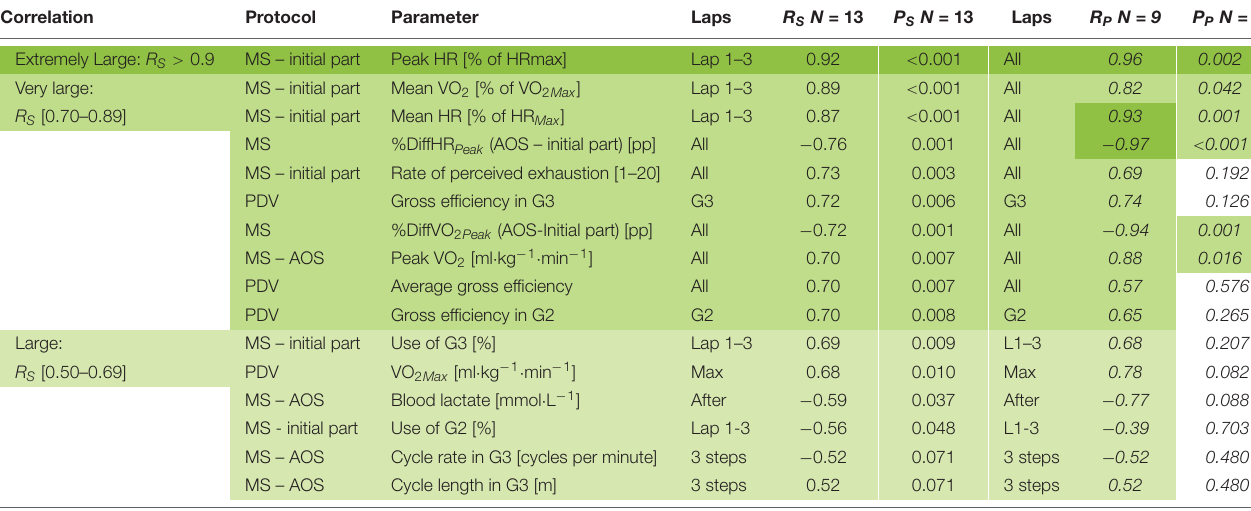
TABLE 4 | Spearman’s rank order correlation ( R S ; for all 13 skiers) and Pearson’s correlation ( R P ; for the 9 skiers who completed the entire protocol without breaks) between ranking (Spearman’s), respectively, time to exhaustion (Pearson’s) in the simulated mass-start (MS) and variables measured during the MS in addition to performance determining physiological variables (PDV) measured on a separate